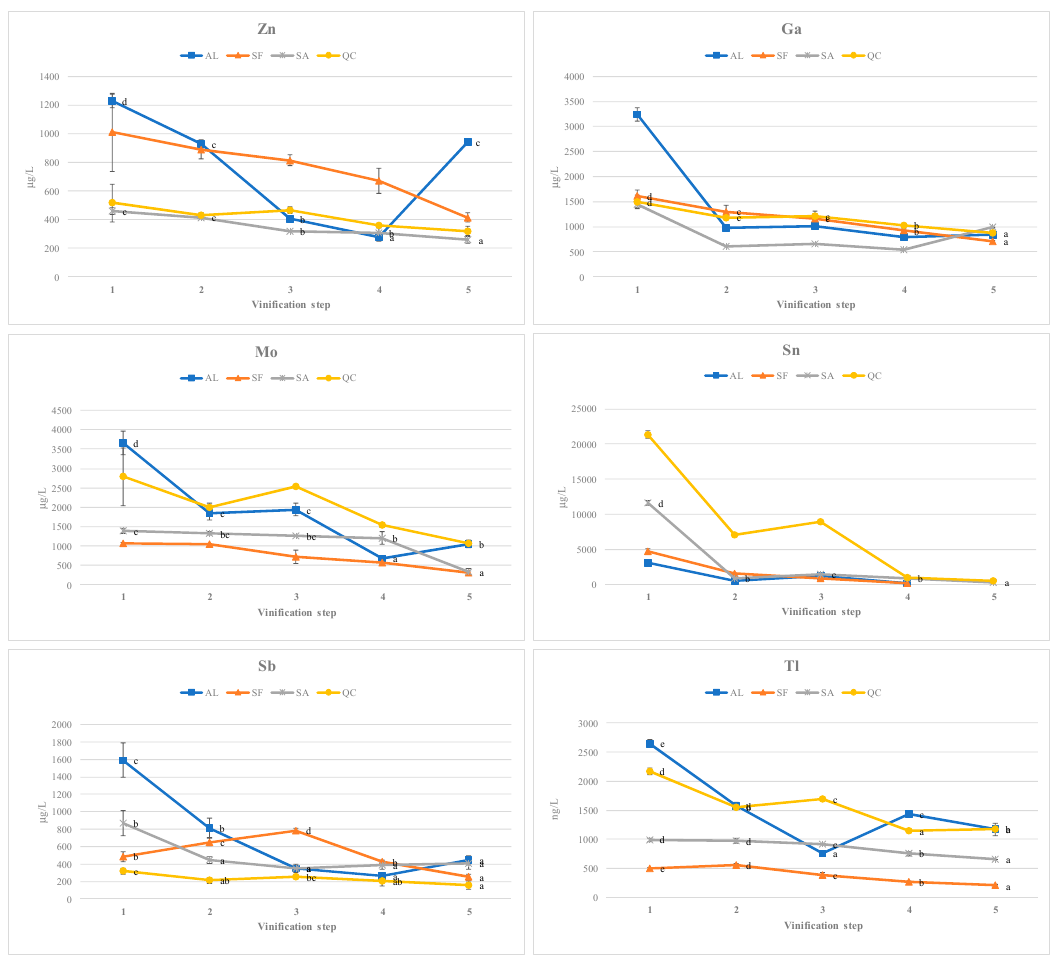
Figure 5. Evolution of heavy metals (contaminant elements) concentrations over vinification, by vineyard of origin. (AL) Vinha de Algeruz; (SF) Quinta de S. Francisco; (SA) Quinta do Sanguinhal; (QC) Quinta dos Carvalhais. Vinification step: (1) after crushing and vatting; (2) after must corrections and inoculation; (3) during the alcoholic fermentation (density approximately of 1030 g/L); (4) after running off; (5) after malolactic fermentation and first racking, before any blending to preserve the trace to the vineyard of origin. For each element and vineyard, results correspond to mean values (and corresponding standard deviations) of three replicates and corresponding analytical duplicates ( n = 6). Means followed by the same letter are not significantly different at 0.05 level of significance. Values are not followed by significance letters indicate that a non-parametric test (Kruskal-Wallis test) was applied and comparison of means was not carried out.